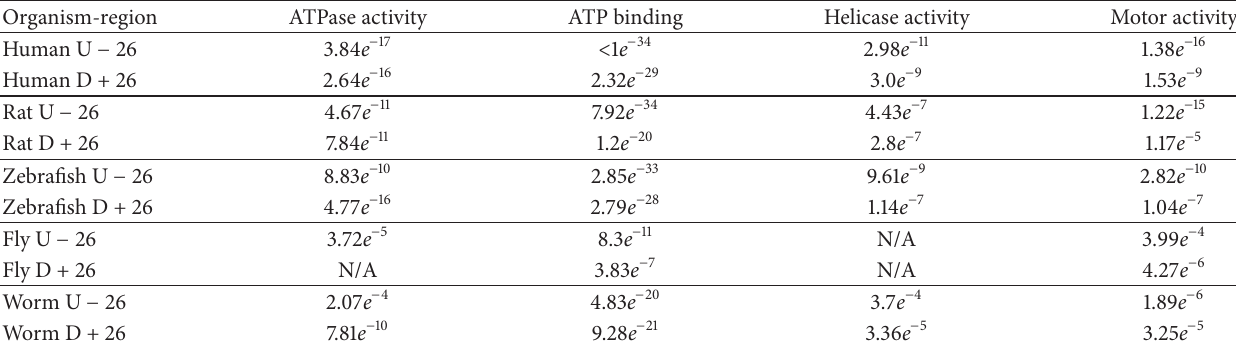
Table 1: 𝑃 values indicating significance of ontological enrichment across